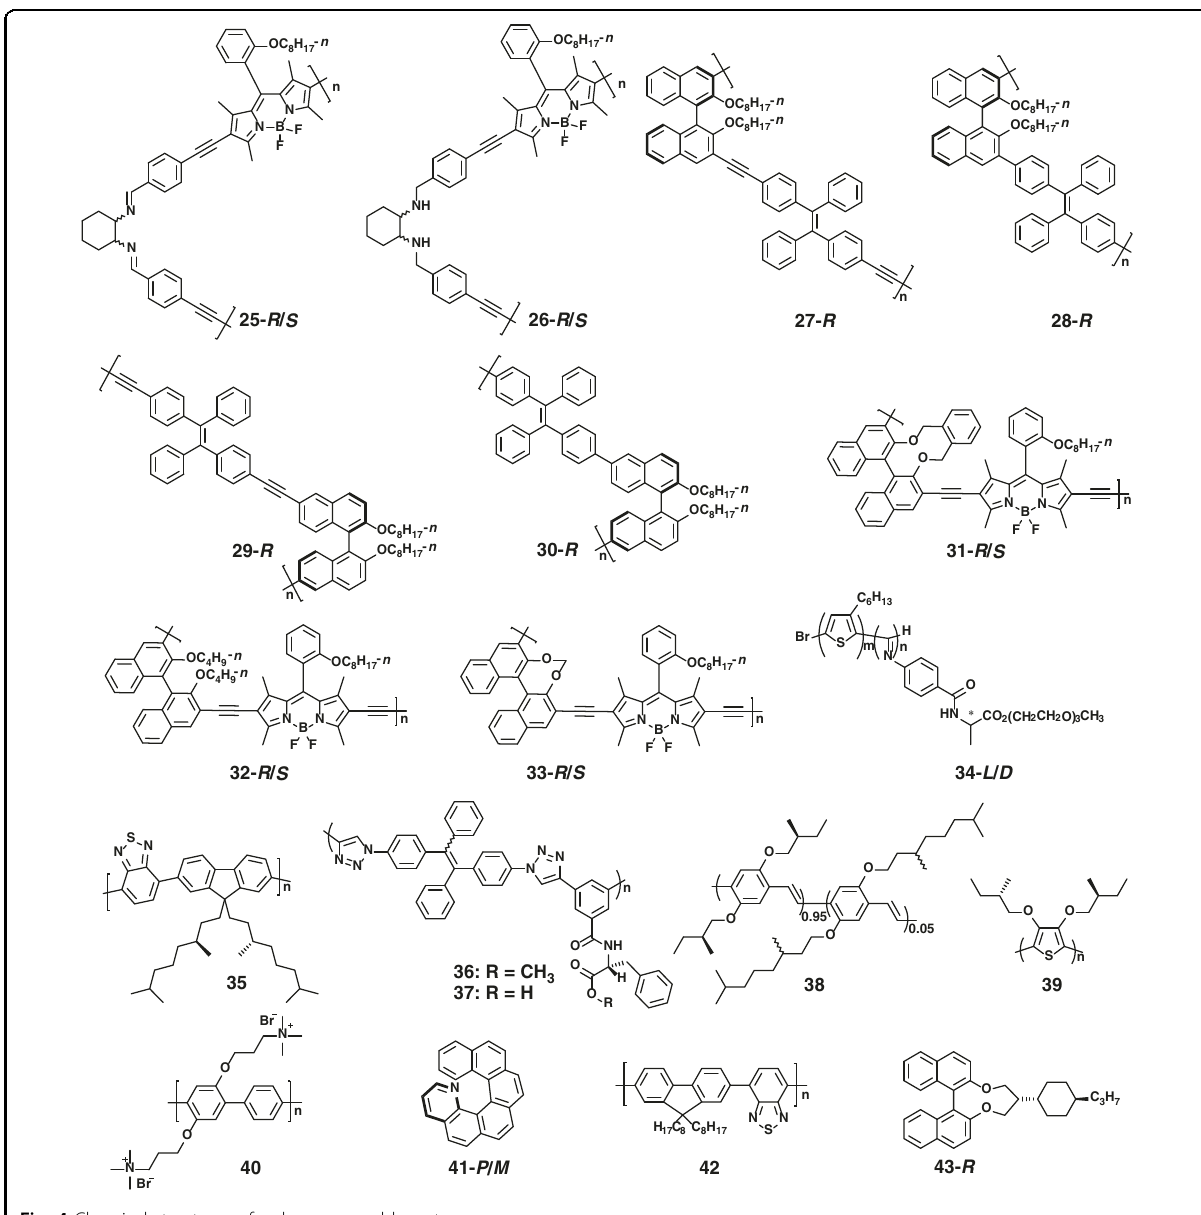
Fig. 4 Chemical structures of polymer-assembly